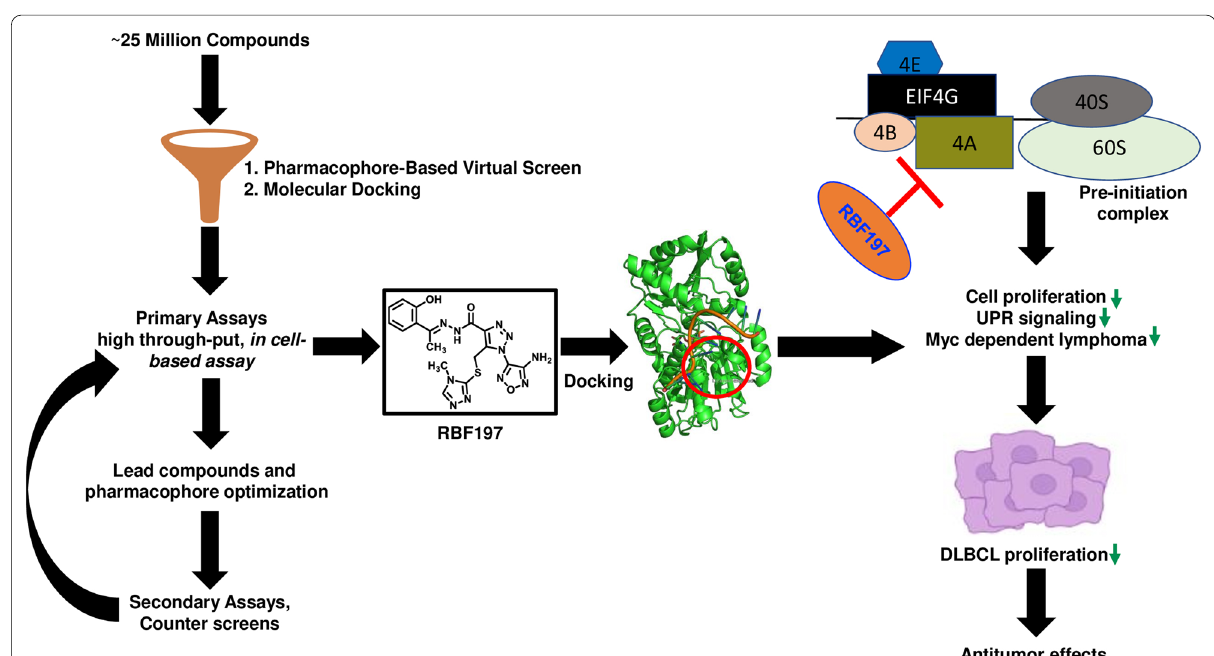
Fig. 8 Anticancer effect of RBF197: Schematic summary of identification of novel eIF4A inhibitors and RBF197 targeting eIF4A translational capacity to suppress